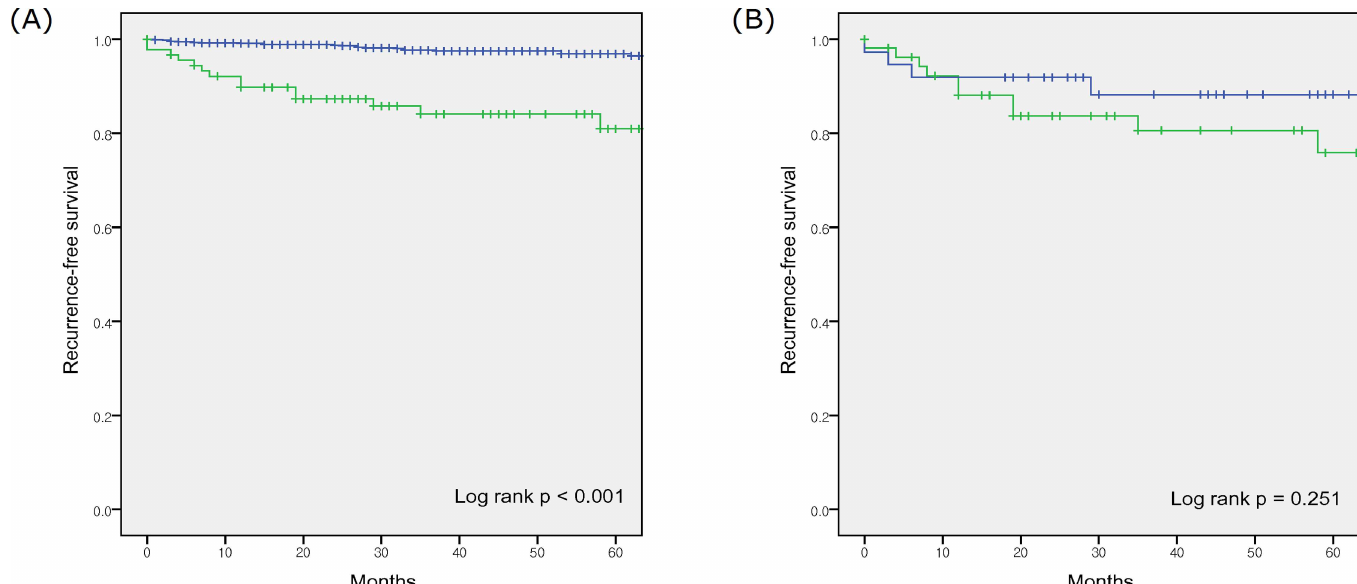
Fig 1. Kaplan-Meier survival curves for recurrence-free survivals. (A) the pT1 (blue curve) and pT3a upstaginggroups (green curve), and (B) the partial nephrectomy (blue curve) and radical nephrectomy (green curve) subgroupsof the pT3a upstaginggroup.